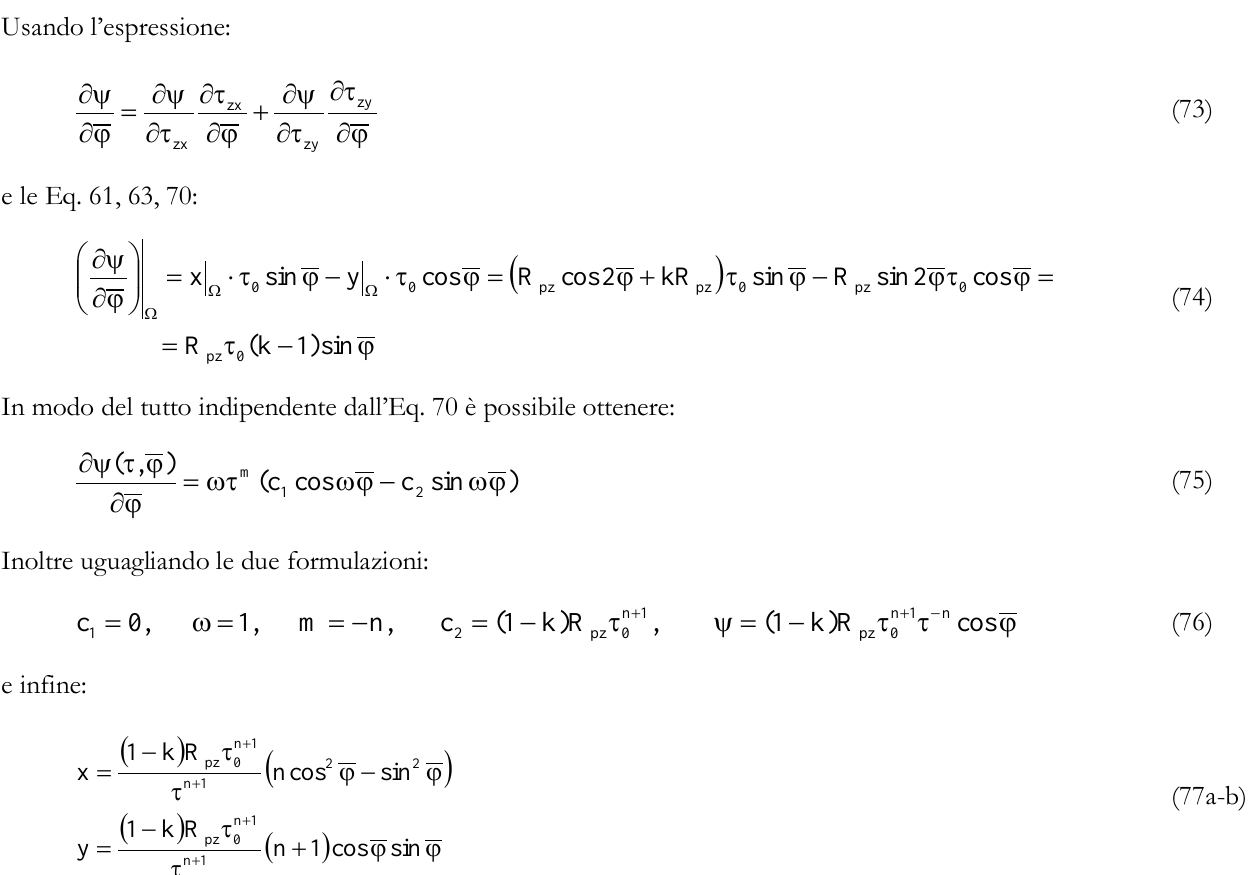
Figura 14: Zona plastica per un materiale incrudente secondo legge di